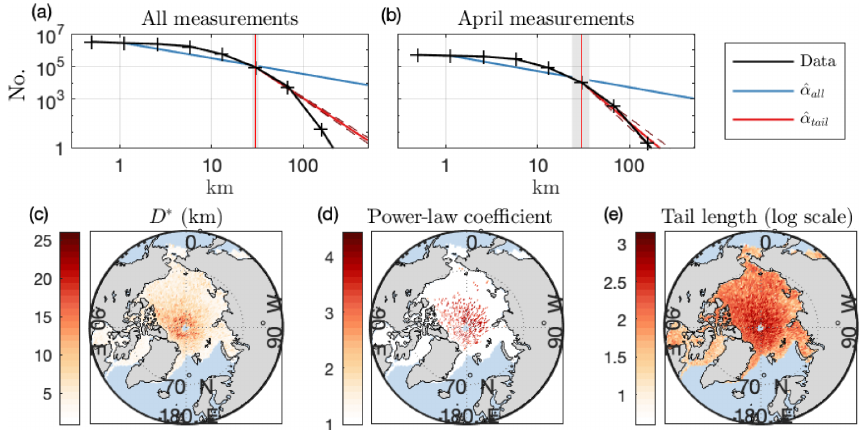
Figure 4. Examining the power-law hypothesis. (a) Histogram of all chord lengths recorded in the Arctic for the months November–April (black). Bin centers are indicated by hashes and are logarithmically spaced. The blue line is power-law fit to all observed sizes according to Eq. (14). The red line is power-law fit to the tail. Dashed red lines are fit lines using the ± 1 standard deviation values of ˆ α . The red vertical line is the most likely beginning of the power-law tail, D ∗ , with shaded region ± 1 standard deviation in D ∗ . (b) Same as (a) , but for measurements in April. (c) Maximum likelihood estimate of the beginning of the power-law tail, D ∗ (km) for all measurements at each geographic location over the observational period. Only locations with N > 1000 are plotted. (d) Maximum likelihood estimate of power- law tail exponent, ˆ α tail , for the same points. Colored values have more than 200 chord lengths in the tail and p > 0 . 1. Zero values are those locations plotted in (c) but where either p < 0 . 1 or there are fewer than 200 measurements in the tail. (e) Number of chord lengths in the tail (above D ∗ ) at each